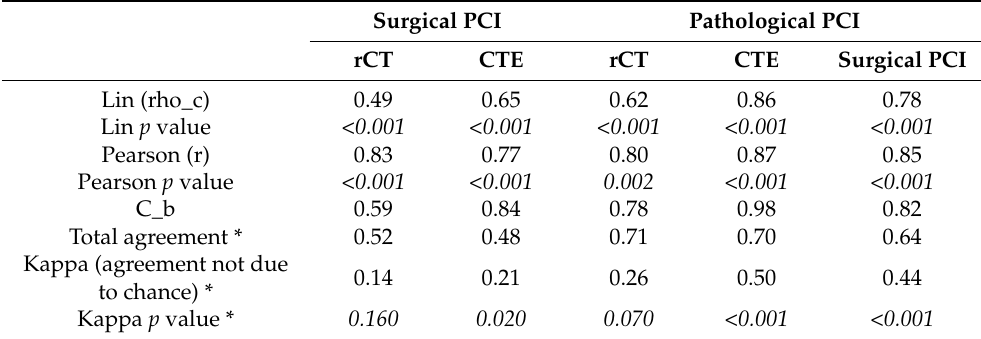
Table 4. Agreement and correlation analysis between PCI quantifications, routine CT or CT enterog- raphy, using surgical and pathological PCI values as reference standards. Surgical PCI Pathological PCI rCT rCT Surgical